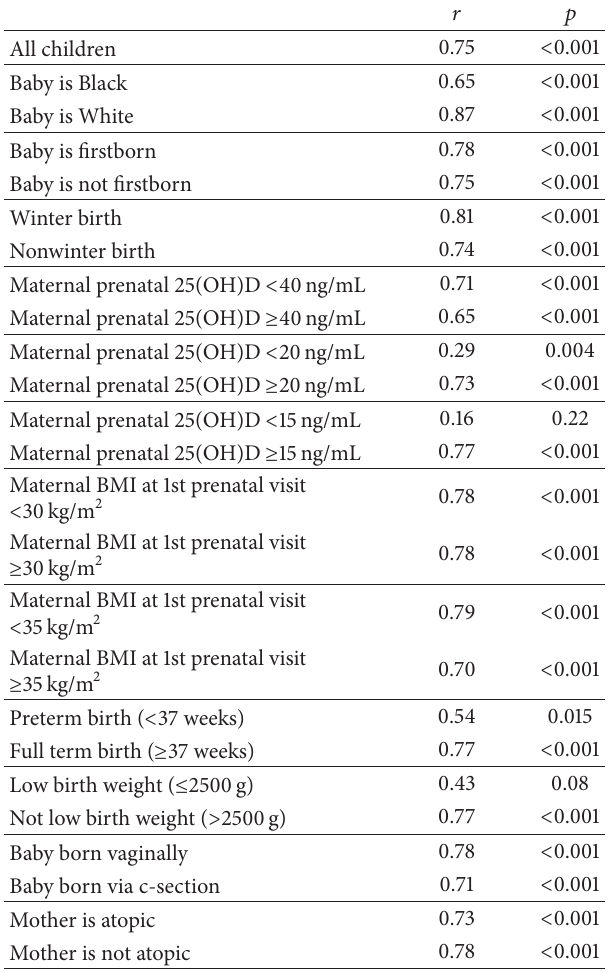
Table 3: Spearman correlations between prenatal 25(OH)D and cord blood